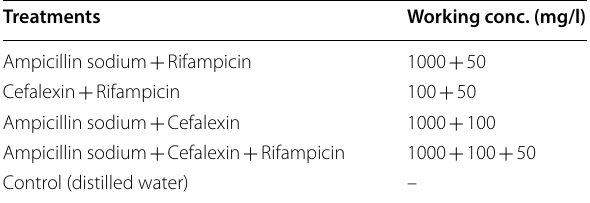
Table 3 Combination of different antibiotics treatments applied to control HLB in infected Kinnow